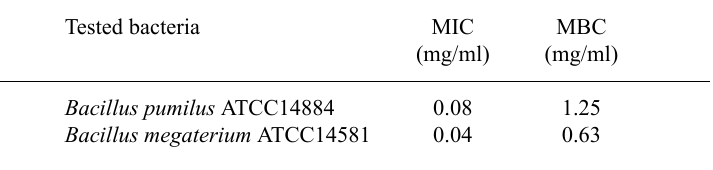
table 2. MIC and MBC values of S. polyanthum L. extracts against B. pumilus and B.